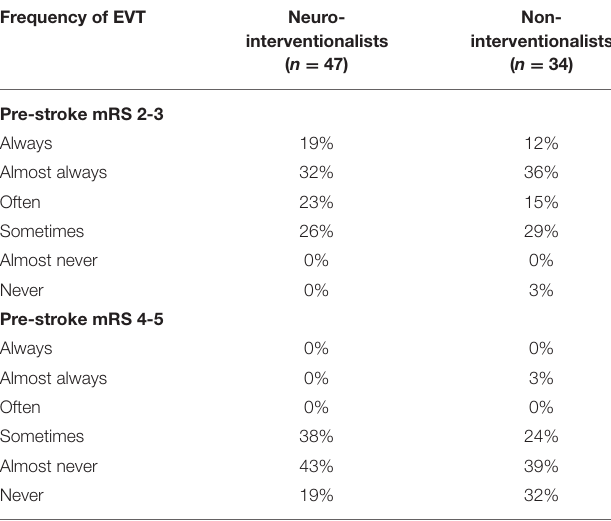
authors total was 33/119 (28%). The denominator for the SVIN TABLE 2 | Frequency of EVT for mRS 2-3 and mRS 4-5 by